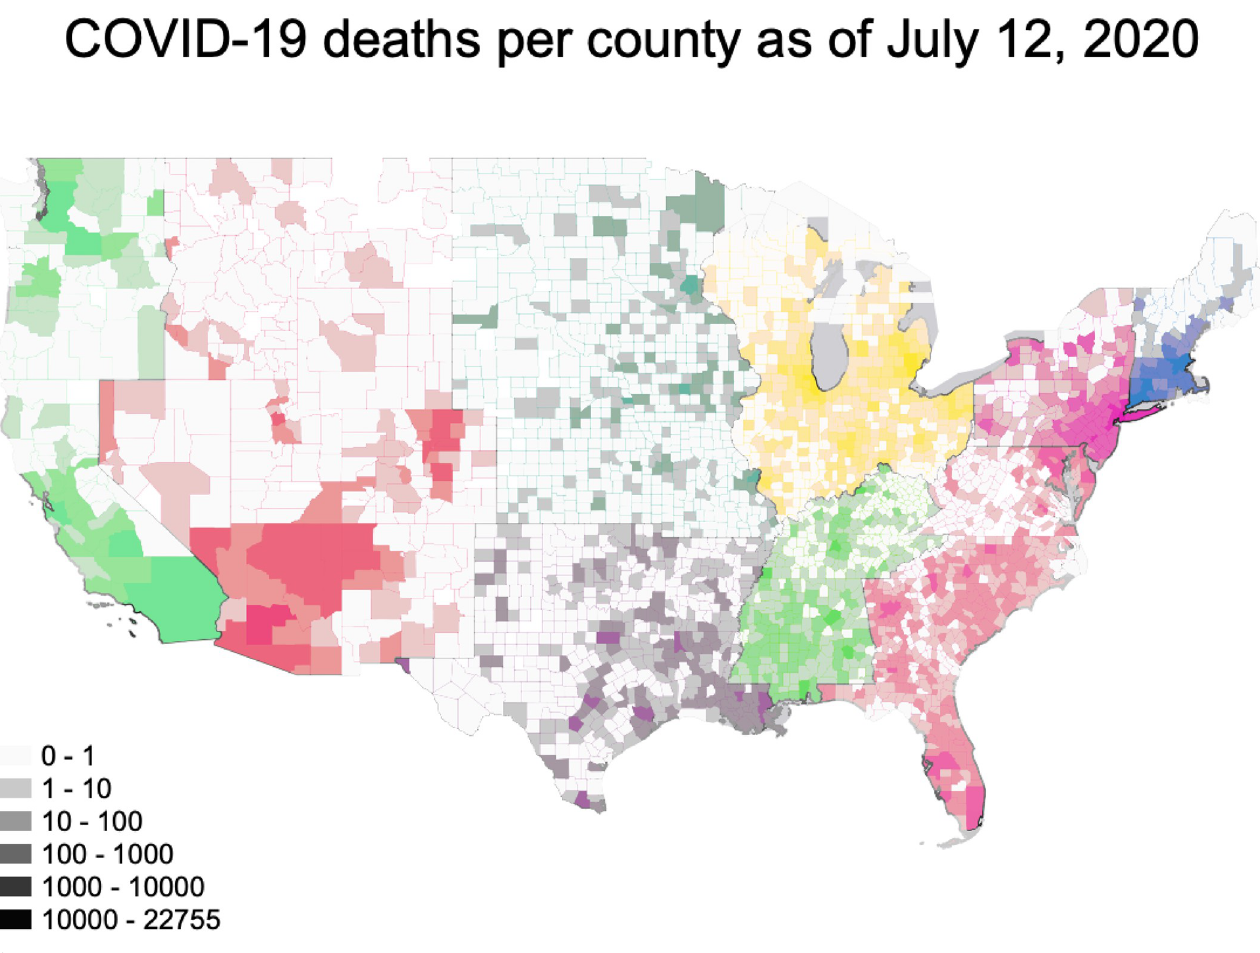
Fig 1. https://doi.org/10.1371/journal.pone.0240151.g001 associated with a higher number of reported COVID-19 deaths (Table 2). Each additional per- centage point of farmworkers in a county was associated with 5.79 more deaths (5.51 directly, 0.28 via indirect ‘spillover’ to the next county, p < 0.001), while each additional percentage point of individuals living in poverty was associated with 4.41 additional deaths (4.20 directly,